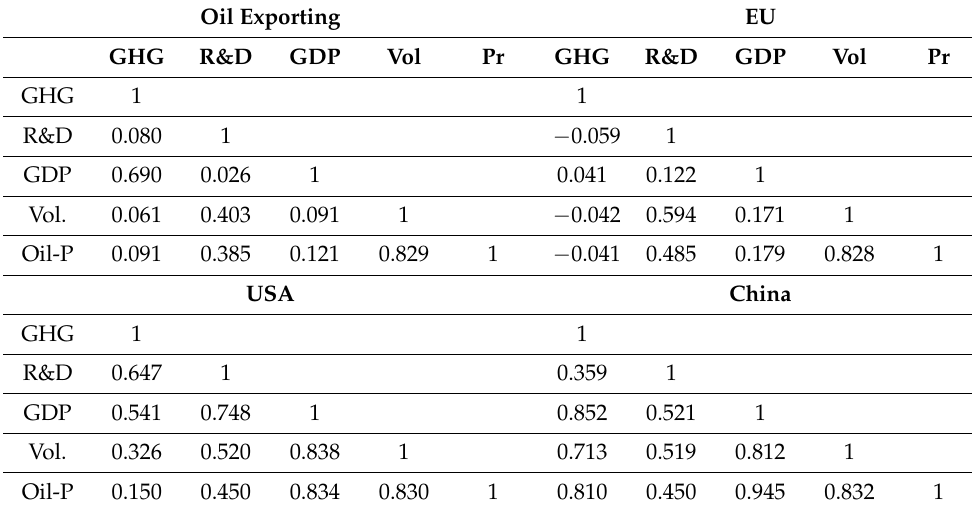
Table 2. Results of the correlation